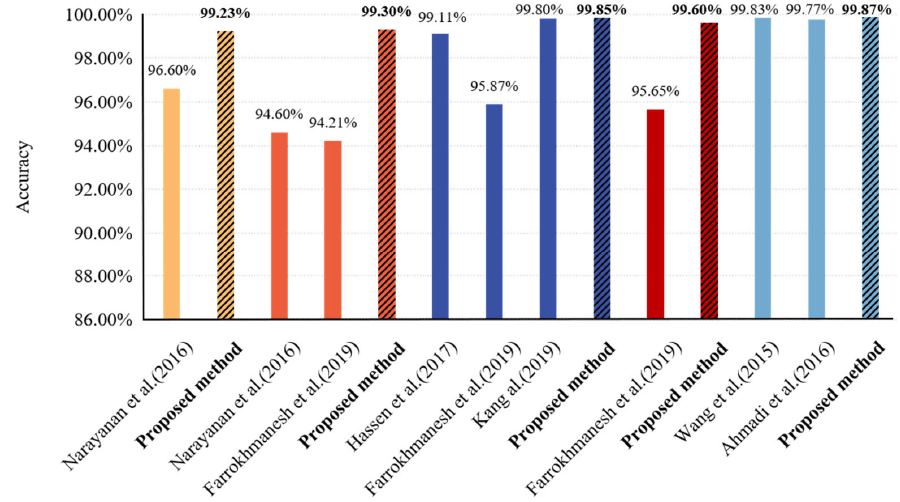
Figure 6. Our model is compared to recent research on the BIG2015 dataset [19,37–41]. Narayanan et al. [37] utilized PCA to reduce the dimension of gray image represen- tation converted from malware and used KNN to classify malicious software. For the BIG2015 dataset, the experimental fi ndings demonstrate that the system has a classi fi ca- tion accuracy of 96.6%. In contrast, our fusion feature set not only includes image infor- mation (Asm_Pixel), but also inconsistent opcodes, assembly codes, and other information that are more bene fi cial to classify malware. It proves that the fusion feature set containing multiple category features is more conducive to classifying malware families. Therefore, under the same KNN classi fi cation algorithm, this paper has achieved a classi fi cation ac- curacy of